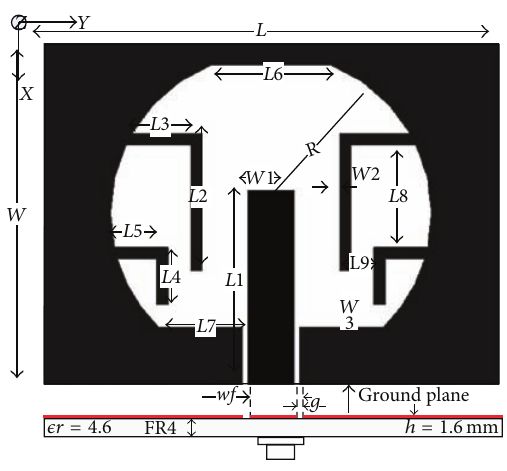
Figure 1: Proposed antenna geometric